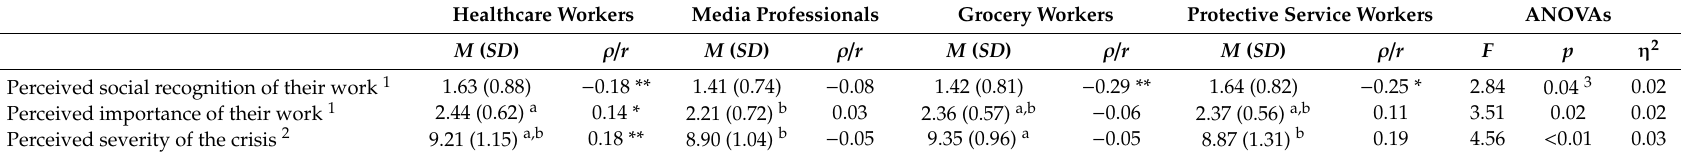
Table 7. Average levels of perceived social recognition, perceived importance of the own work during the pandemic, perceived severity of the COVID-19 crisis, and their associations with psychological impact (IES standardized factorial score), and di ff erences between groups. Healthcare Workers Media Professionals Grocery Workers Protective Service Workers